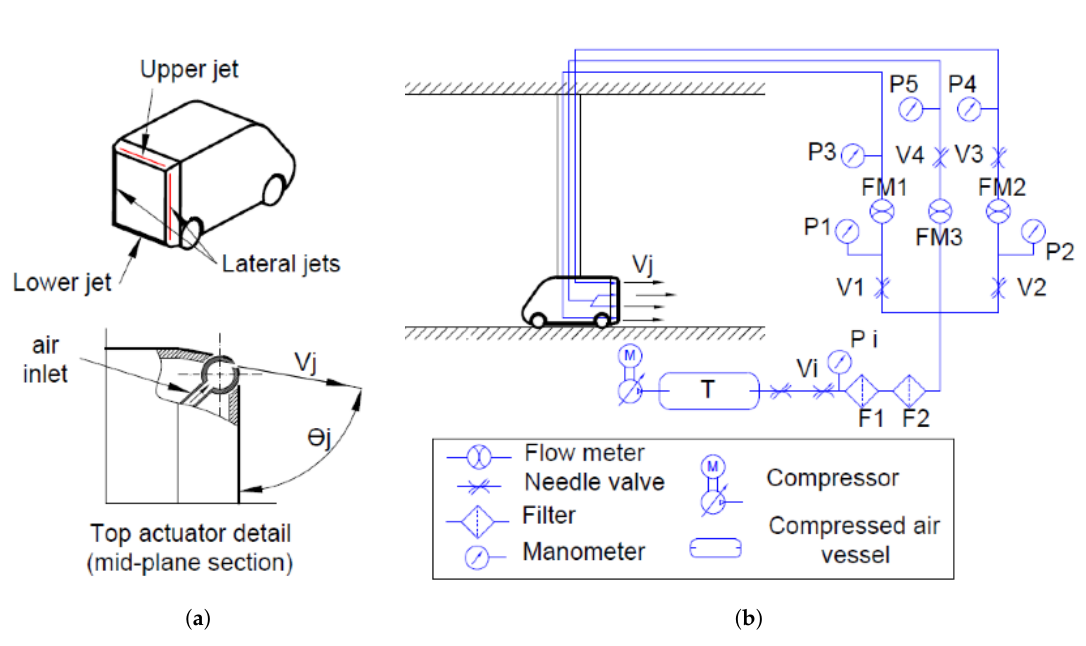
Figure 2. Flow actuation: ( a ) details of the slots; and ( b ) blowing speed control